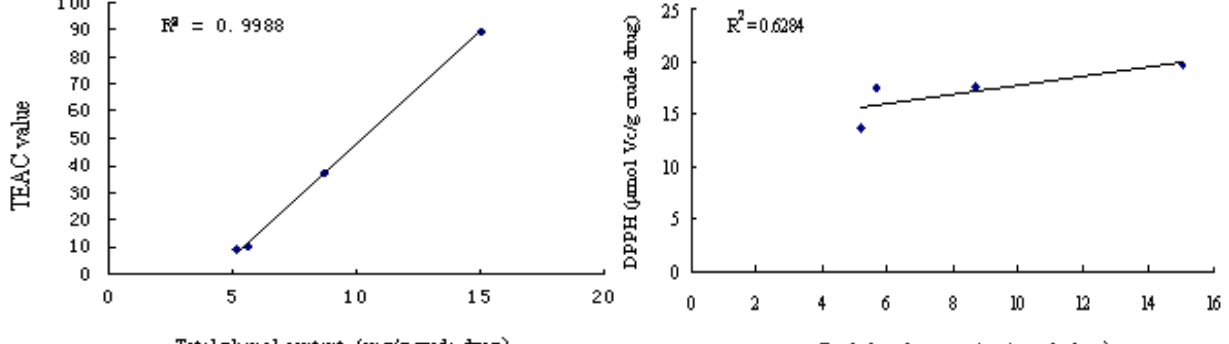
Figure 3. The correlation between total phenols content and TEAC, DPPH, FRAP